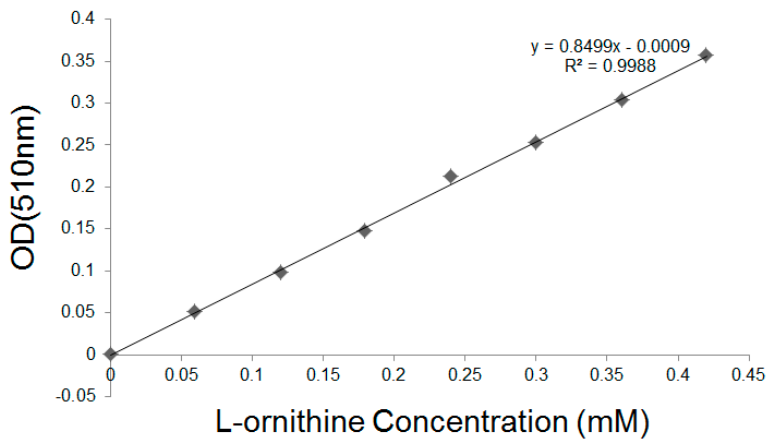
Figure 10. The calibration curve of L ‐ ornithine.